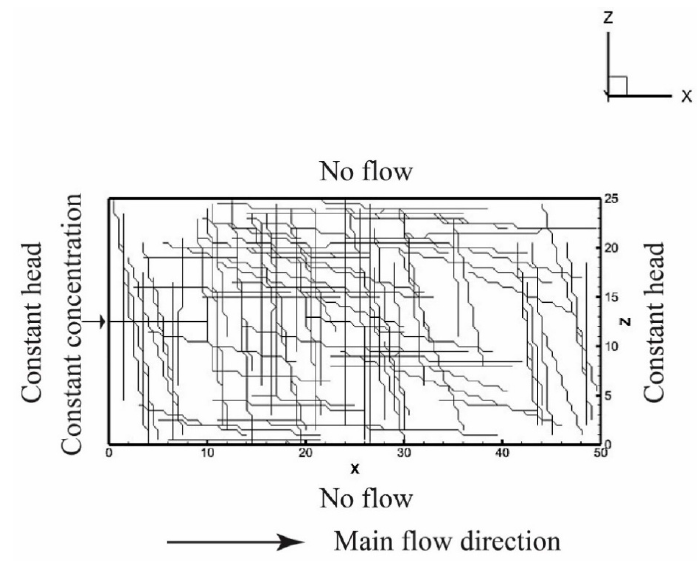
Figure 1. Map of the fractured domain, showing flow geometry and boundary conditions. Note that